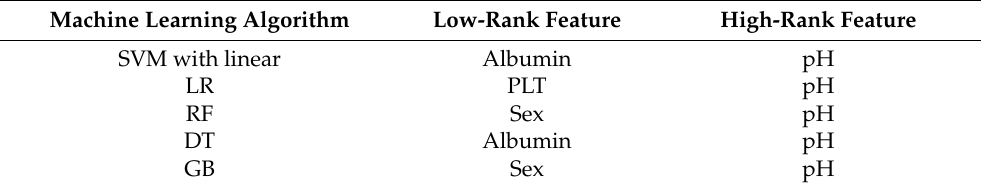
Table 3. Performance result of recursive feature elimination of each algorithm. Low-rank features are albumin, platelet, and sex. High-rank feature is pH. Machine Learning Algorithm Low-Rank Feature